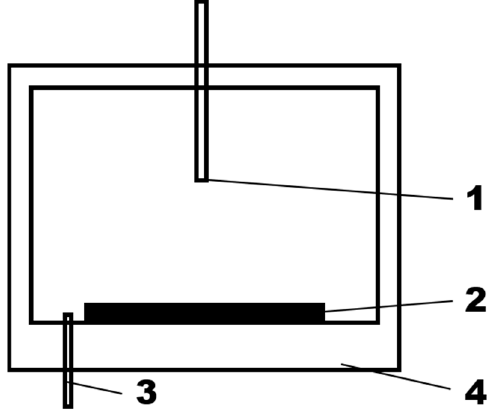
Figure 1. The schematic of the MWCNTs synthesis plant. 1—a device for a vapor–gas mixture; 2—heating device on which the catalyst is located; 3—the device for connecting a vacuum pump; 4— housing.